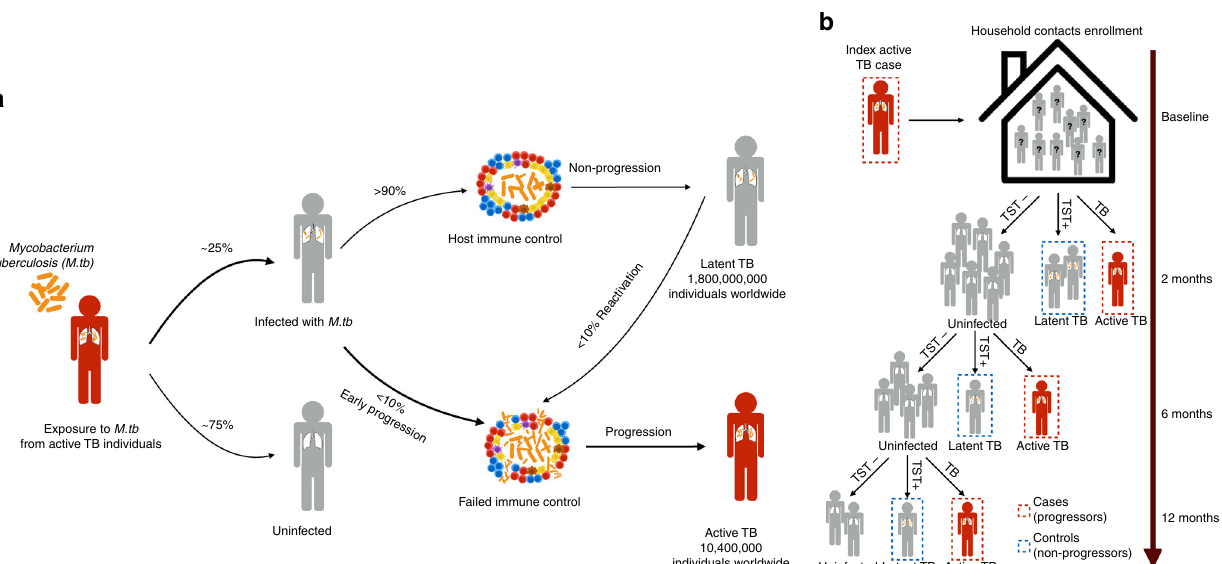
Fig. 1 Overview of phases of Mycobacterium tuberculosis ( M.tb ) infection and sample collection. a Pathophysiology of TB. Major steps following from the initial exposure to M.tb are outlined, with the percentages of individuals progressing between steps taken from the WHO TB report 14 . b Schema of cohort collection. In this study, we focus on a genetic study between recently exposed active pulmonary TB cases (progressors) and subjects with tuberculin skin test (TST) positive results, who did not progress to active TB (non-progressors). Index cases had sputum with con fi rmed TB. Controls were recruited in the same household as index cases, with 12 month follow up periods to con fi rm infection status using